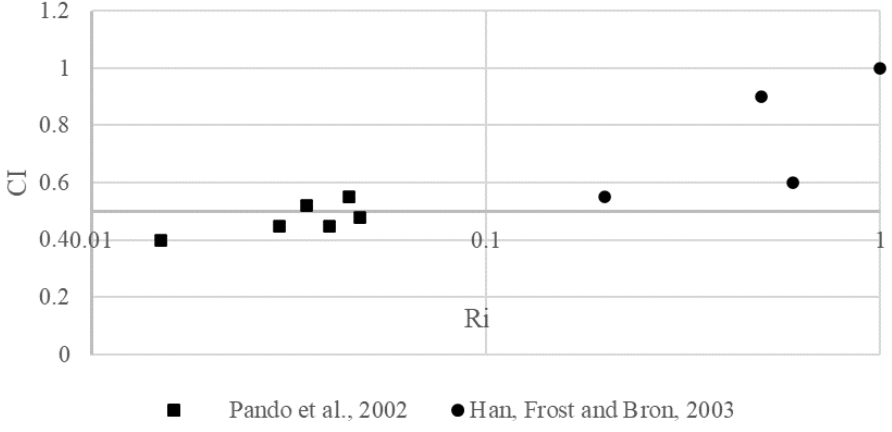
Figure 9. Coefficient of interaction (CI) between the FRP surface and the roughness index